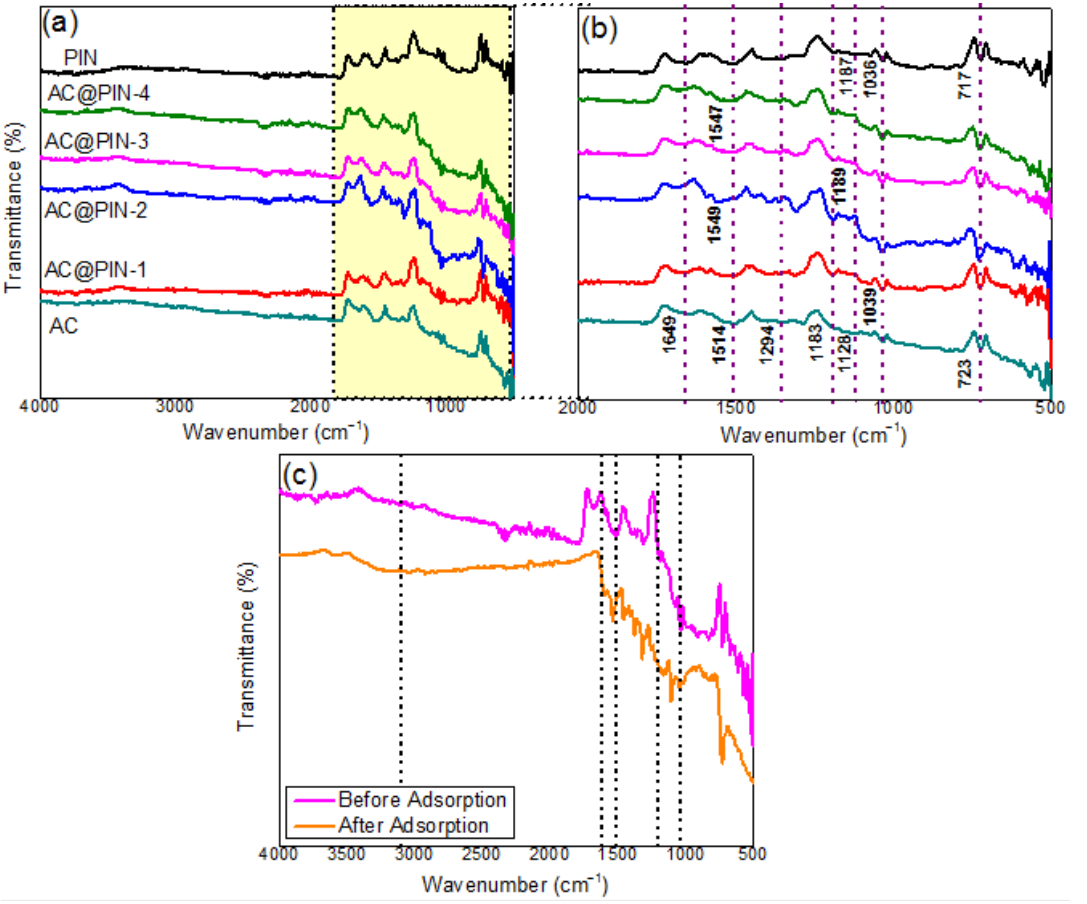
Figure 1. FTIR spectra of ( a ) PIN, AC, and AC loaded various AC@PIN composites, ( b ) re-scaled spectra from 2000 to 500 cm − 1 , and ( c ) comparative spectra of AC@PIN-3 before and after adsorption of MG dye.